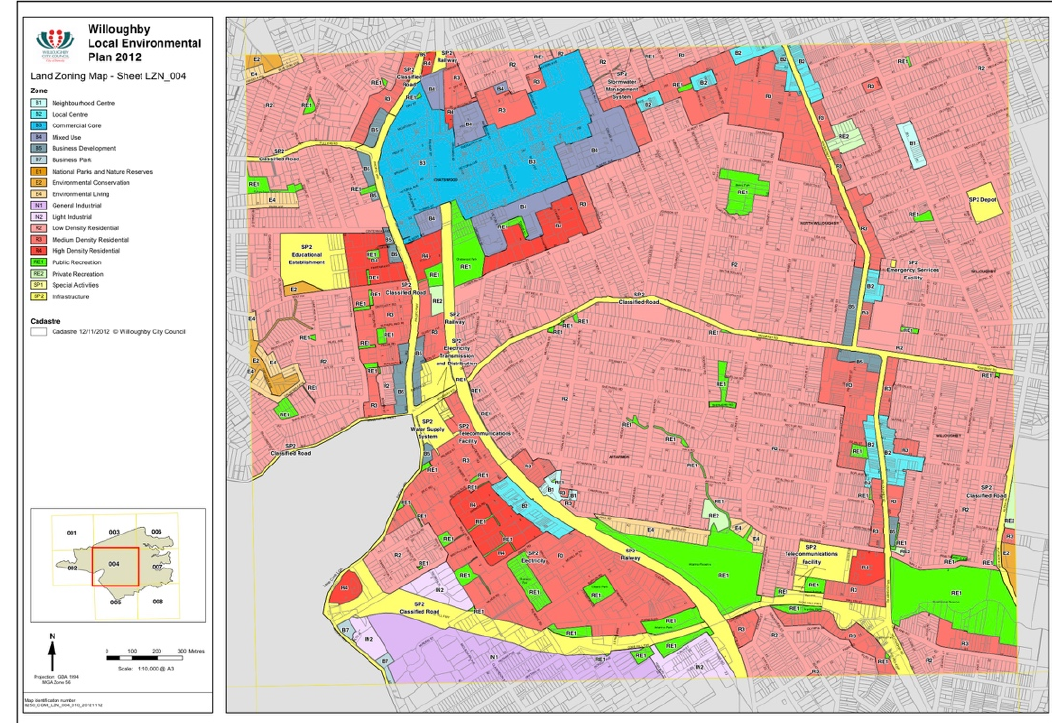
Figure A2. Chatswood Land Zoning Map LEP. Chippendale [24]